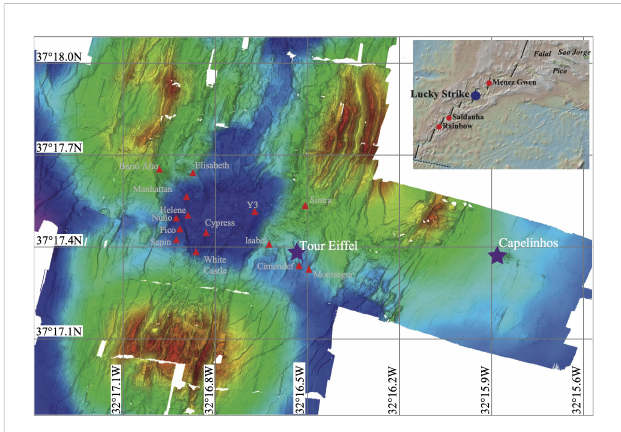
FIGURE 1 Bathymetric map modi fi ed from Ondre ́ as et al. (2009), representing the location of the different active sites of the LSHF. Capelinhos and Tour Eiffel sites are marked with a purple